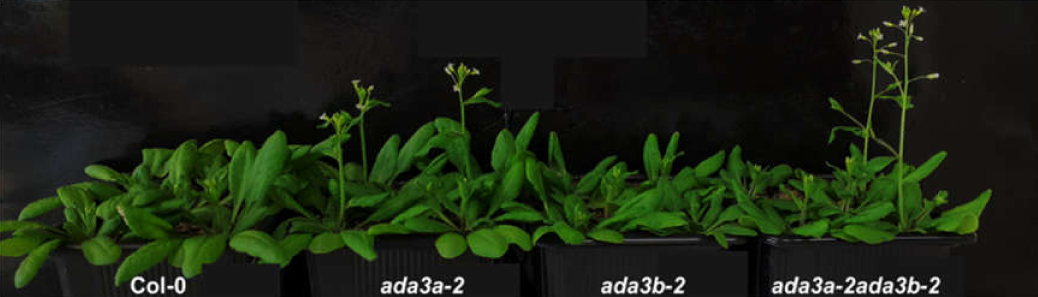
Figure 4. ADA3a affected flowering in Arabidopsis. Photo of approximately 4-week-old Col-0, ada3a-2 , ada3b-2 , and ada3a-2ada3b-2 mutant plants grown under long-day conditions.